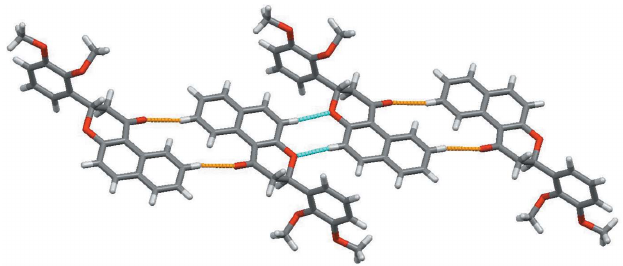
Figure 2 Part of the crystal structure of the title compound, showing the weak C— H (cid:3)(cid:3)(cid:3) O hydrogen bonds forming R 2 (14) dimers as yellow lines. An 2 additional pair of intermolecular hydrogen bonds (blue lines) link the dimers to form a chain.